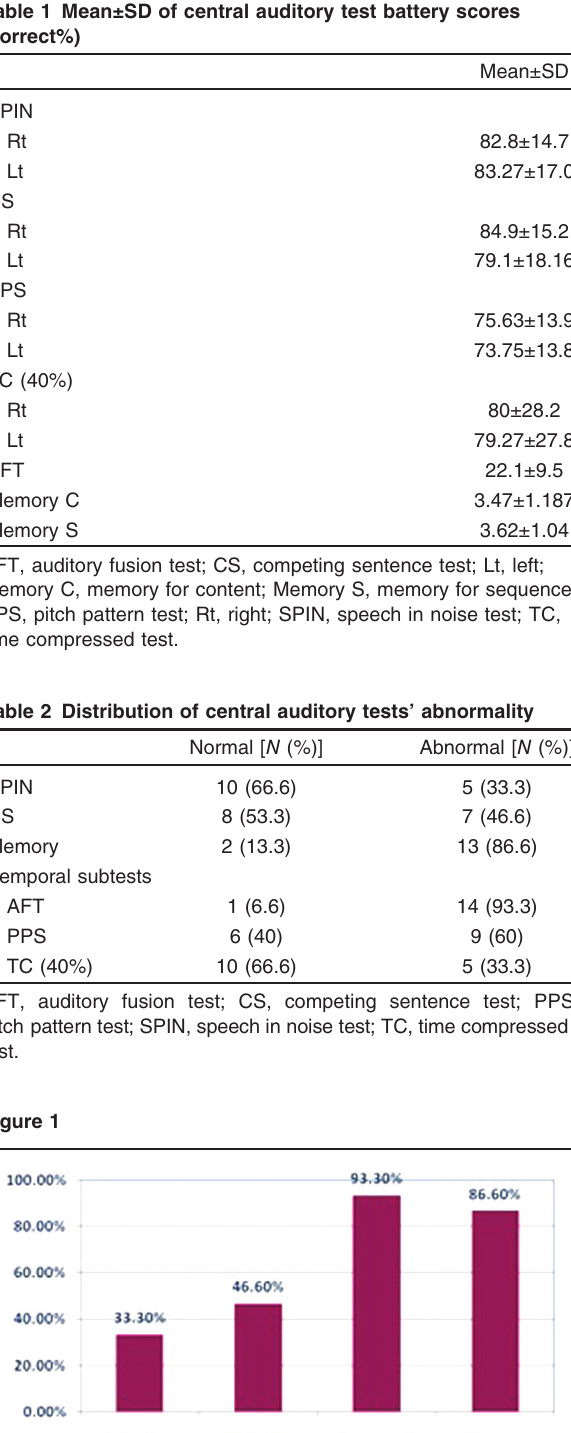
Distribution of central auditory ability